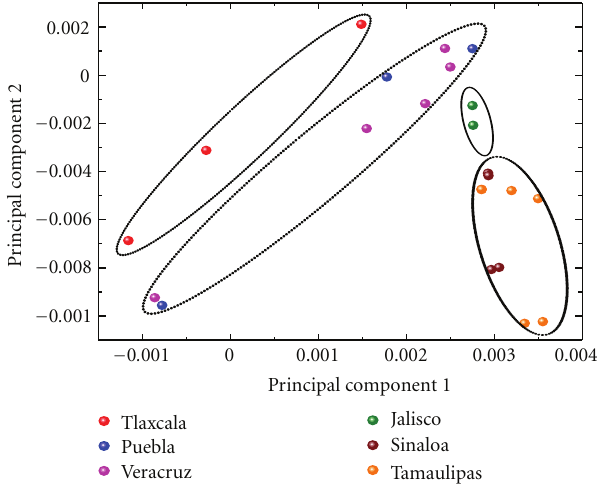
Figure 2: PCA for phenolic compounds in chilli samples grouped by region.